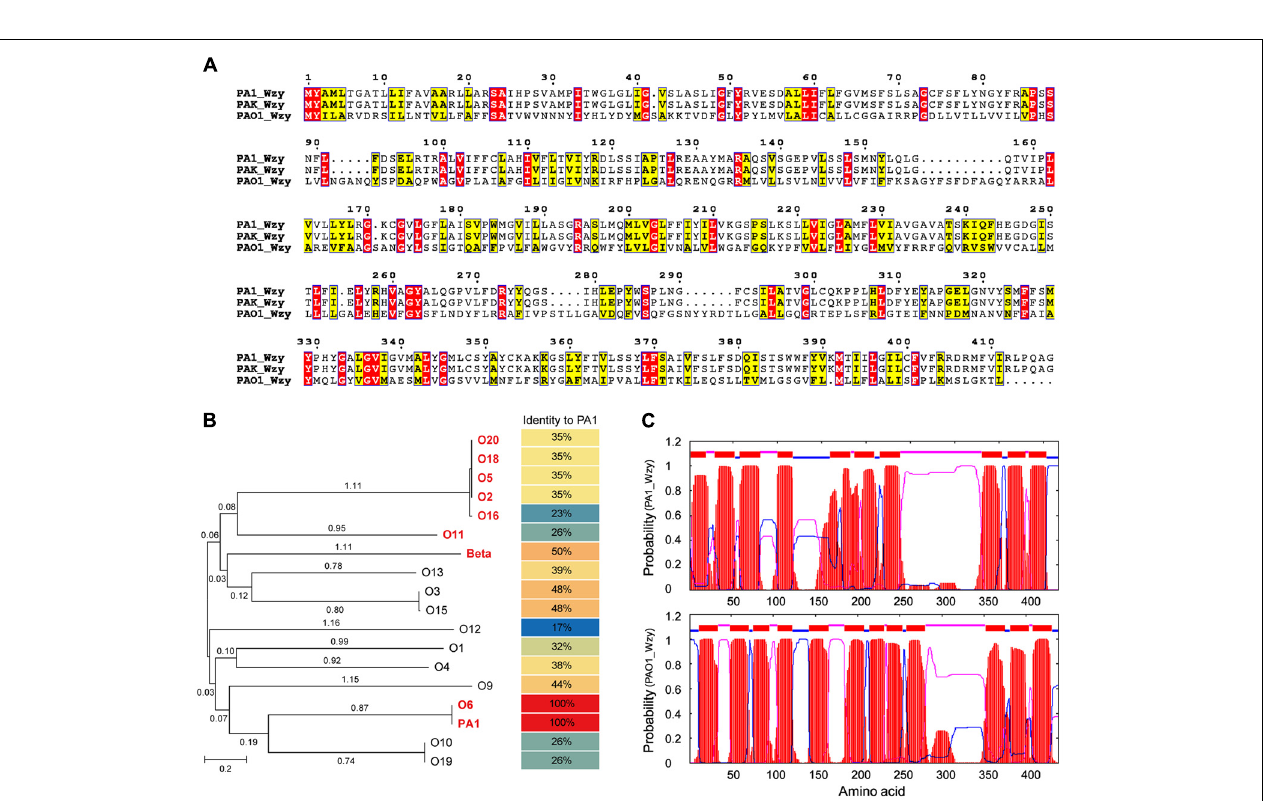
FIGURE 4 | In silico analyses of PA1_Wzy. (A) Sequence alignment of Wzy. Identical residues are shown as white letters boxed in red, similar residues are written with black characters boxed in yellow. (B) Phylogenetic analysis. Wzy homologs belonging to different P. aeruginosa serotypes were subjected to phylogenetic analysis. The serotypes labeled in red and bold letters indicate that Wzy activity has been experimentally determined in these serotypes. Beta represents phage D3-coding Wzy that mediates β -linkage of O -antigen repeat unit. (C) Transmembrane topology analysis. Red: transmembrane helices. Blue: cytoplasmic loops. Pink: periplasmic